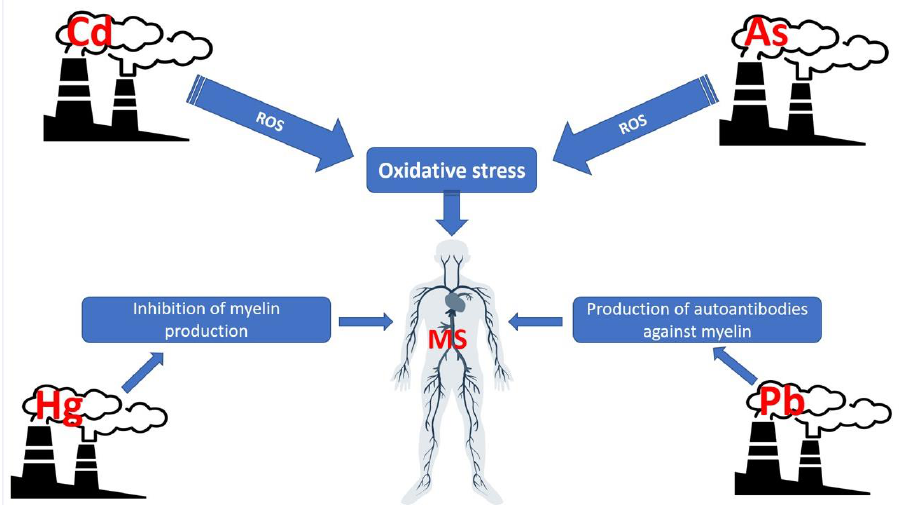
Figure 1: Graphical